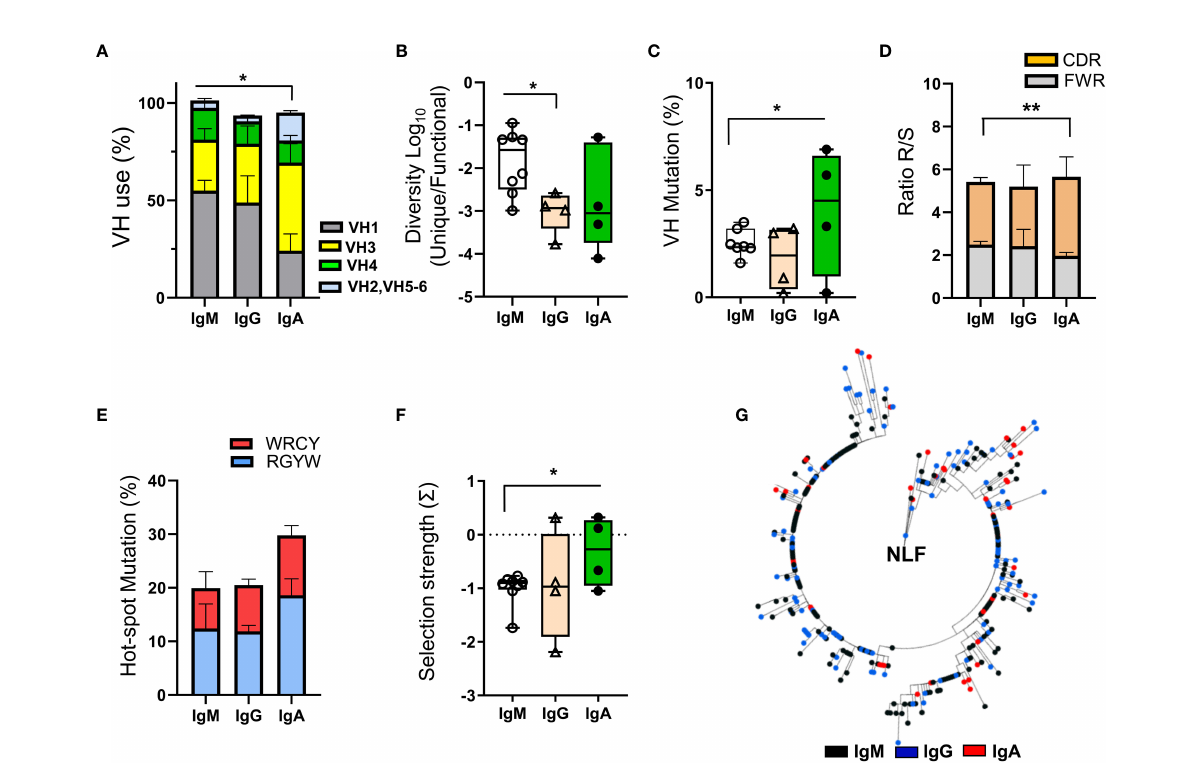
FIGURE 7 BCR repertoire analysis in NLF. The NLF repertoires of VDJ- IgM (n = 9), -IgG (n = 4) and IgA (n = 4) rearrangements were determined after RT- PCR-speci fi c ampli fi cations and sequencing by NGS. The obtained sequences were processed, cleaned and analyzed as indicated in Materials and Methods ( “ Bioinformatics ” section). (A) VH usage frequency on sequences from each individual repertoire of NLF samples. Shown are the means ± SEM. See Table S2 for sequence numbers. (B) The diversity of the repertoires was calculated as the ratio between unique sequences and functional sequences. Each dot represents the value for the repertoire of all sequences obtained in the same sample, and overlaid are box- and-whisker plots showing the median, the fi rst quartile to the third quartile and the minimum and maximum values. (C) VH mutations in IgS repertoires. Data are represented as in (B) . (D) The ratio of replacement (R) and silent (S) mutations located in the CDRs and FWRs is shown as mean ± SEM. (E) Frequency of SHM hotspots in the AID motifs WRCY and RGYW. Data are shown as mean ± SEM. (F) Antigen selection strength (quanti fi ed using the BASELINe algorithm). Data are represented as in (B) . (G) Clonal tree obtained for the VH3-23-JH4 family clone identifying IgM (n = 198), IgG (n = 113) and IgA (n = 46) sequences, from a single NLF sample. The analysis was performed based on a minimal substitution model using MUSCLE software, with alignment curation using Gblocks and tree interference with PhyML. Data were compared using an unpaired two tailed Student´s t-test. *p < 0.05; **p <